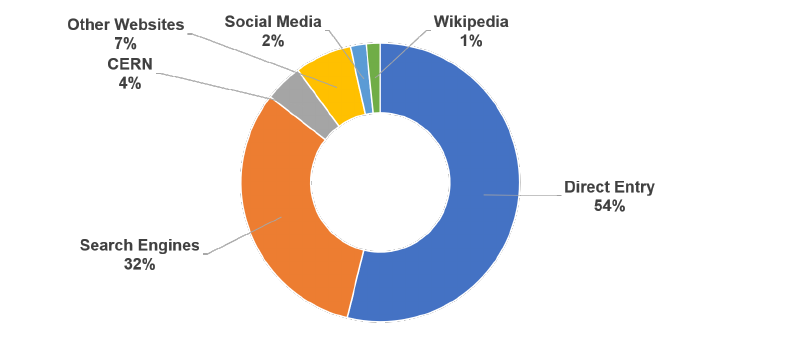
Figure 5. The referrer statistics from Piwik. The majority of the website visitors is through direct entry and the secondary source is search